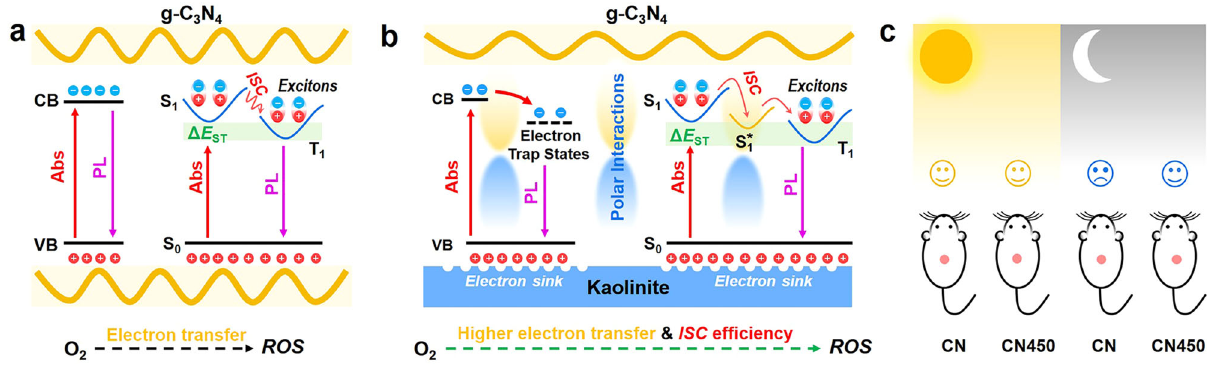
Fig. 6 Schematic description of graphitic carbon nitride-kaolinite ’ s principle of enhancing monolinear oxygen yield and antimicrobial mechanisms. a The charge-carrier-involved mechanisms with “ electron trap states ” for reactive oxygen generation. b The exciton-involved mechanisms with “ singlet- excitons trap states ” for 1 O 2 generation. c Antimicrobial and wound-healing